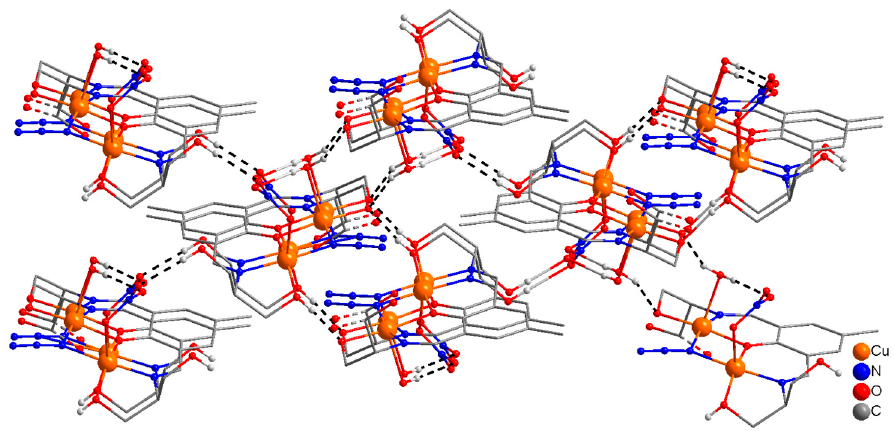
Figure 6. Perspective view of 3D-structure of 3 .